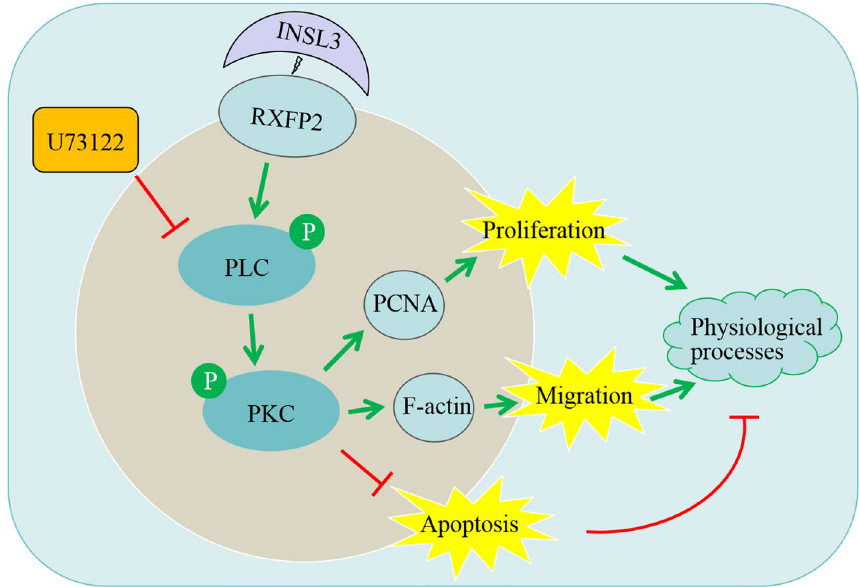
Fig. 5 Graphic abstract. INSL3 regulated gubernacular cell proliferation, migration, and apoptosis via the PLC/PKC signaling pathway. Specifically, INSL3 binding to RXFP2 may up-regulate the expression levels of PCNA and F-actin by activating the PLC/PKC signaling pathway to promote the proliferation and migration of gubernacular cells and inhibit their